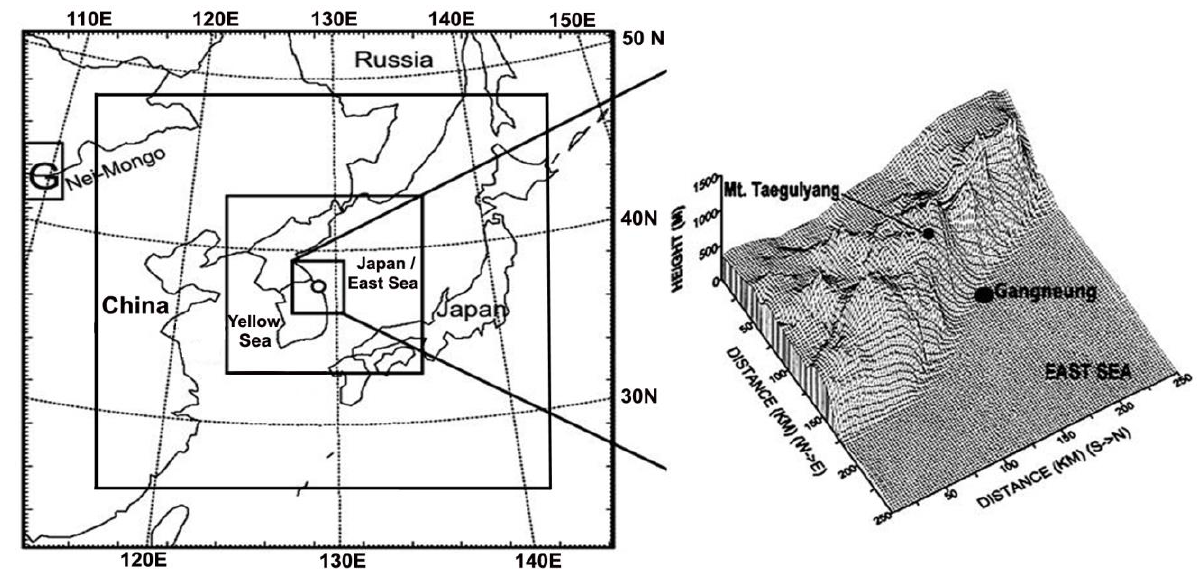
Figure 1 . Topographical features in the vicinity of the Korean peninsula (left) including Figure 1. Topographical features in the vicinity of the Korean peninsula ( left ) including Gangneung Gangneung city (right), in which an aerosol sampler was equipped [24,29,30]. Big and small city ( right ), in which an aerosol sampler was equipped [24,29,30]. Big and small squares inside the squares inside the left figure denote the first, second, and third domains with sequential left figure denote the first, second, and third domains with sequential horizontal grid spaces of 27 km, horizontal grid spaces of 27 km, 9 km, and 3 km covering a 91 x 91 grid number for numerical 9 km, and 3 km covering a 91 × 91 grid number for numerical simulation using WRF-3.6 model. simulation using WRF-3.6 model. G (a small square in the left) denotes the Gobi Desert. G (a small square in the left) denotes the Gobi